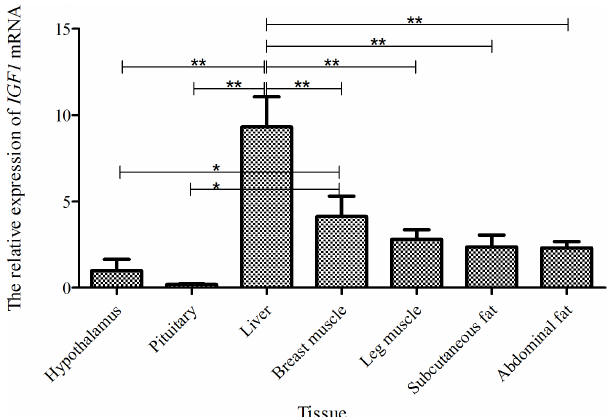
Figure 4. The mRNA expression of the IGF1 gene in different tis- sues of a 5-week-old Shitou goose.